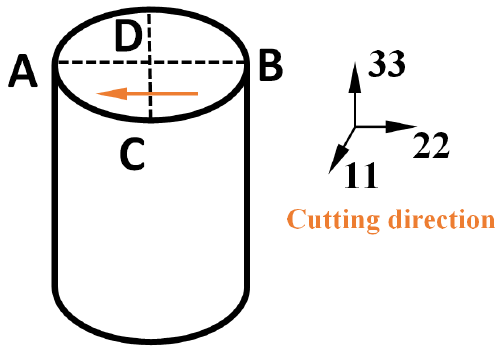
Figure 31. Specimen 2—line segments used for comparing stress levels on planes of cut